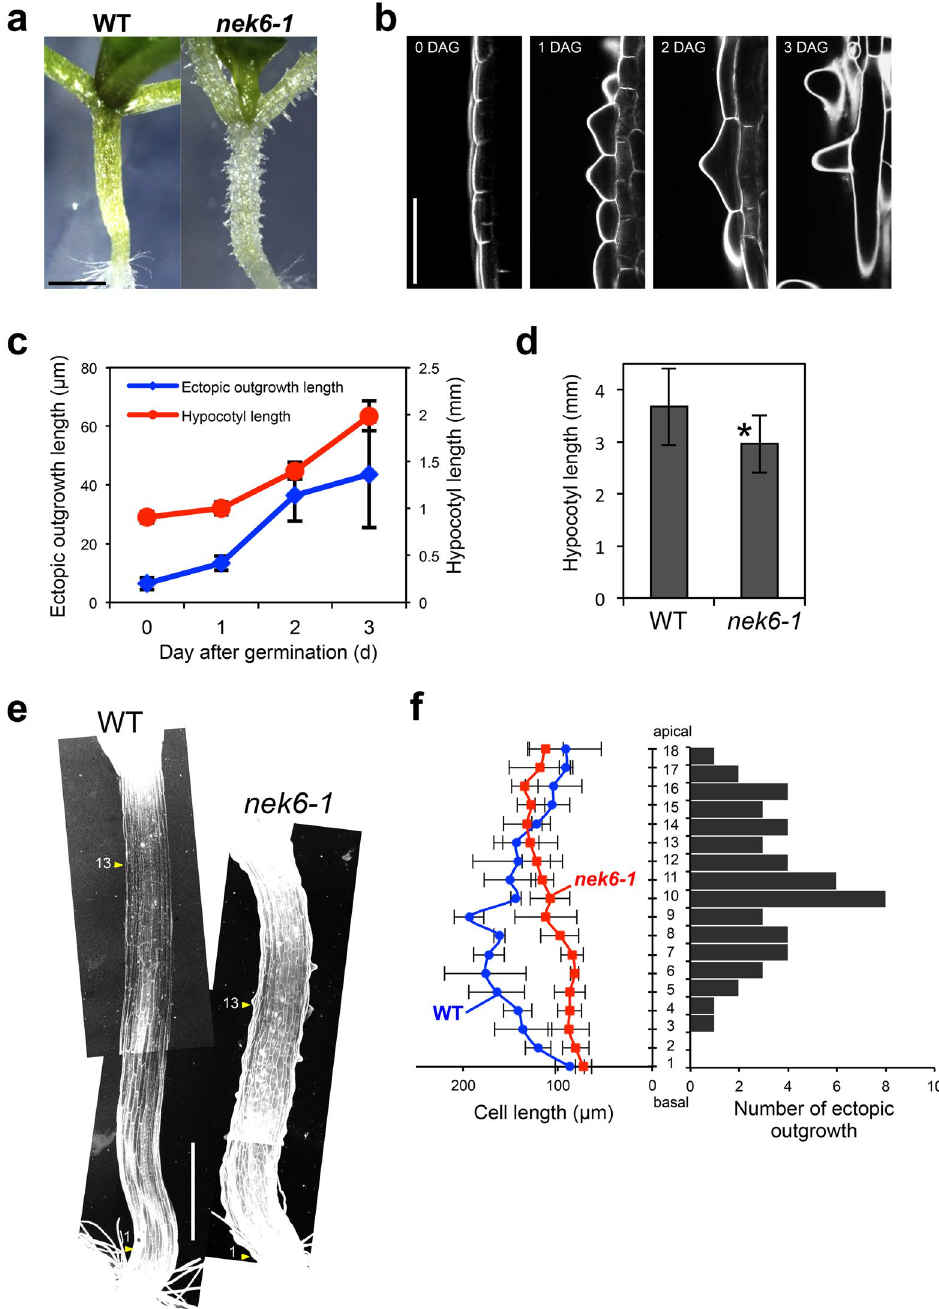
Figure 1. NEK6 suppresses ectopic outgrowth and promotes cell elongation. ( a ) Morphology of wild type (WT) and nek6-1 mutant seedlings grown for 7 days. The scale bar represents 1 mm. ( b ) Morphology of epidermal cells in the hypocotyls of nek6-1 seedlings 0 to 3 days after germination (DAG). The seedlings (0 to 3 DAG) were stained with propidium iodide and observed under a confocal microscopy. The scale bar represents 50 µ m. ( c ) Quantification of length of ectopic outgrowths and hypocotyls in nek6-1 seedlings 0 to 3 days after germination (DAG). Data are displayed as averages ± SD (n = 14 to 21 protrusions and n = 10 hypocotyls). ( d ) Quantification of hypocotyl length of wild type (WT) and nek6-1 seedlings grown for 8 days. Data are displayed as averages ± SD (n = 12). The asterisk indicates significant difference from the value of the wild type ( t -test, P < 0.001). ( e ) Morphology of wild type (WT) and nek6-1 seedlings 3 days after germination (DAG). The seedlings were stained with propidium iodide and observed under a confocal microscopy. Arrowheads represent the cell number in a file of the hypocotyl with respect to the graph in ( f ) (No. 13 cell from the bottom of the hypocotyl). Scale bar represents 50 µ m. ( f ) Quantification of cell length and number of ectopic outgrowth along hypocotyl axes of wild type (WT) and nek6-1 . The vertical axis indicates cell number from bottom of hypocotyl. The left panel indicates cell length along hypocotyl and data are displayed as averages ± SD (n = 10). The right panel shows a histogram of total number of ectopic protrusions in 10 cell